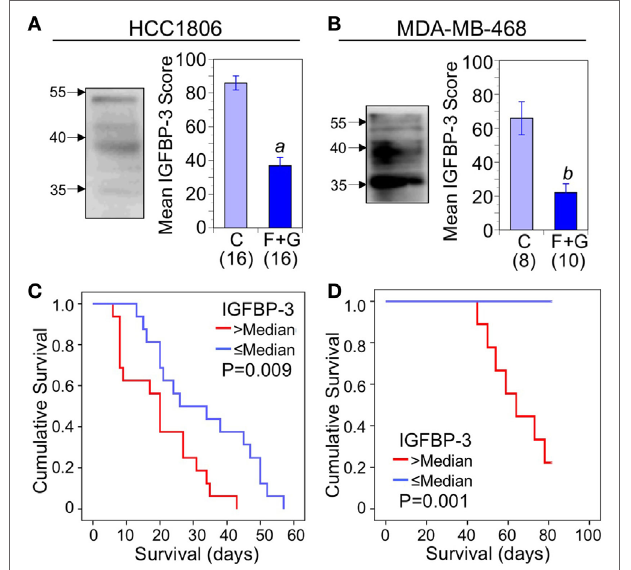
FigUre 3 | The relationship between tumor nuclear insulin-like growth factor binding protein-3 (IGFBP-3) and mouse survival. (a,B) Left: western blot of immunoreactive IGFBP-3 after immunoprecipitation from solubilized nuclei isolated from cultured cells; molecular weight markers in kDa are indicated by arrows. Right: quantitation of immunohistochemistry (IHC) scores for nuclear IGFBP-3 in control mice and mice treated with fingolimod + gefitinib (F + G). For HCC1806 (a) and MDA-MB-468 (B) tumors, mean scores ± SEM are shown, numbers of mice in parentheses. Comparison with controls (2-sided t -test): ( a ) P < 0.001; ( b ) P = 0.001. (c,D) Kaplan–Meier survival curves compare the effect of tumor nuclear IGFBP-3 IHC scores > or ≤ the median value on survival of mice bearing HCC1806 (c) or MDA-MB-468 (D) xenograft tumors. For HCC1806, n ( > median) = 16; n ( ≤ median) = 16. For MDA-MB-468, n ( > median) = 9; n ( ≤ median) =